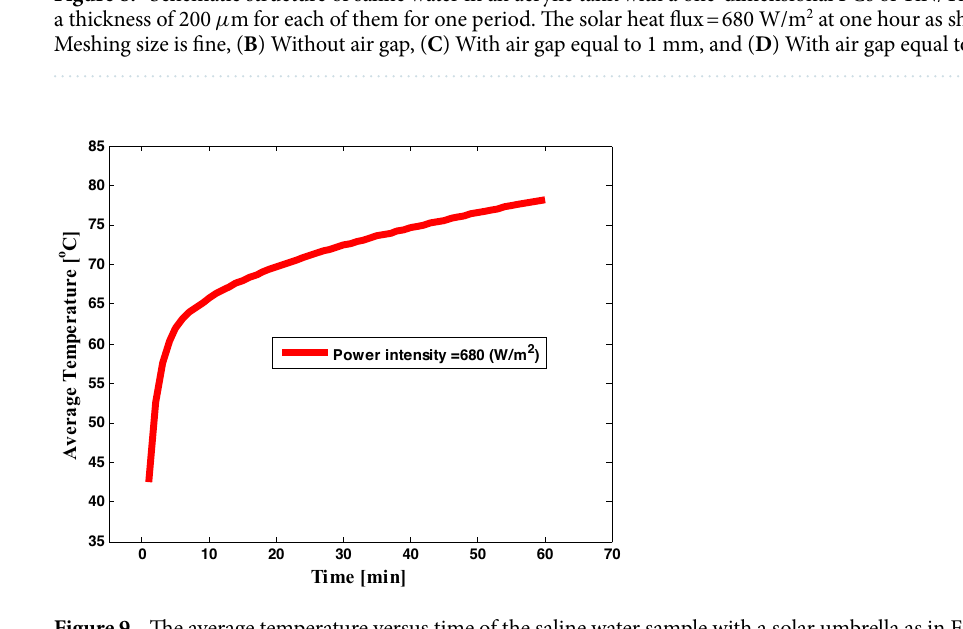
Figure 9. The average temperature versus time of the saline water sample with a solar umbrella as in Fig. 8 surrounding with acrylic